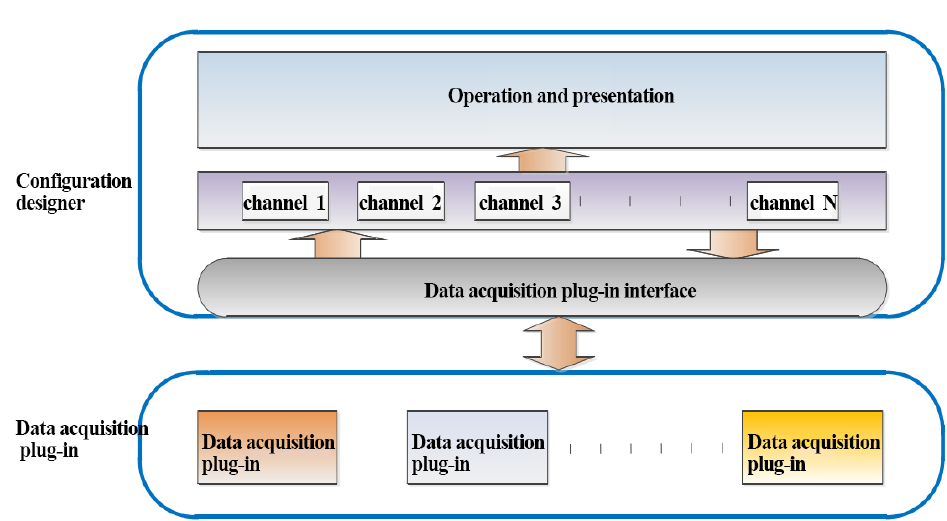
Figure 8. Schematic diagram of data acquisition configuration.